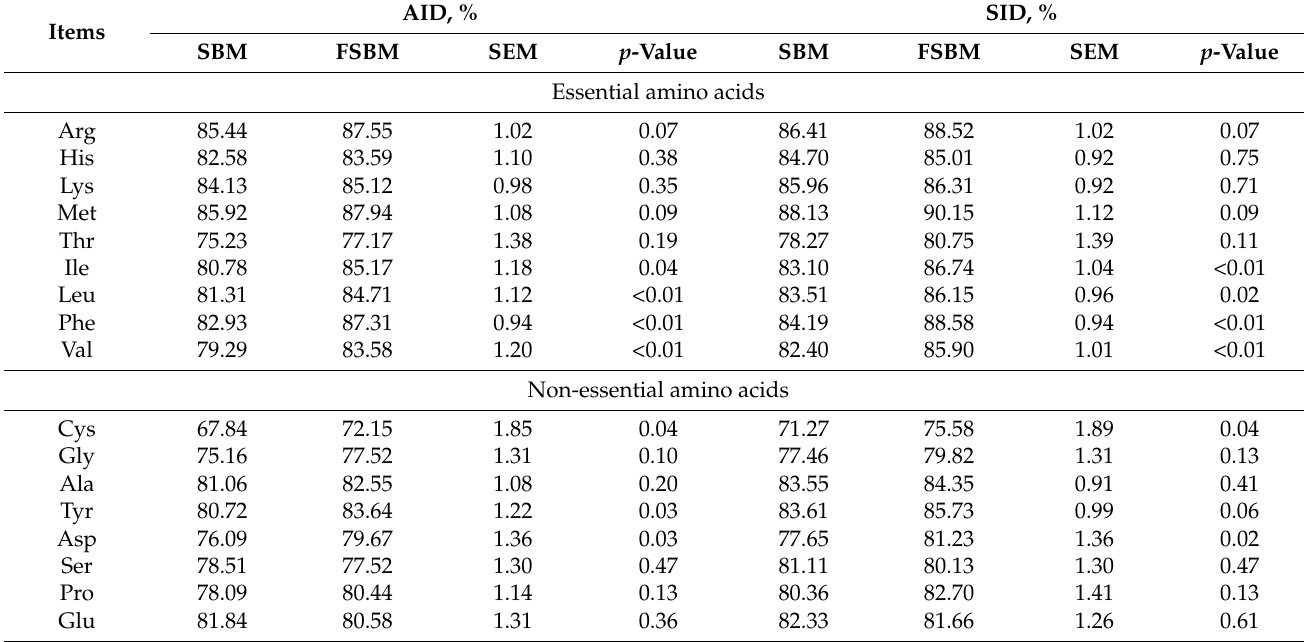
Table 6. Apparent ileal digestibility and standardized ileal digestibility values of amino acids in SBM and FSBM (dry matter basis,